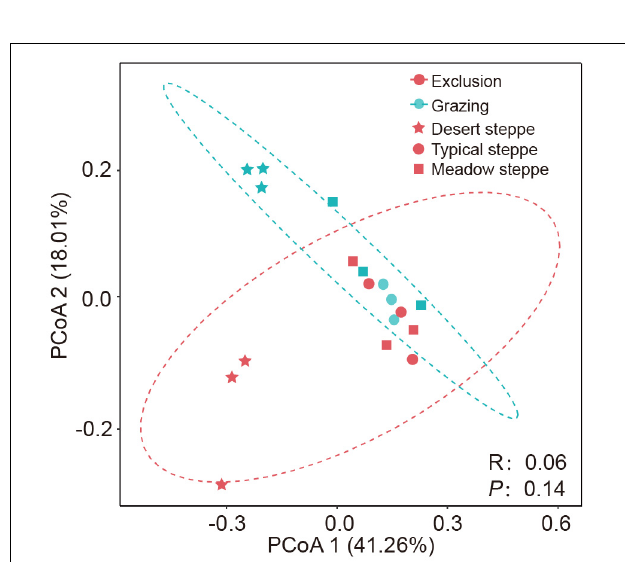
FIGURE 3 | Bacterial community structure assessed by β -diversity patterns using the principal coordinate analysis plots of Bray–Curtis distances. Different color represents exclusion or grazing soils and shape represents grassland types: desert steppe, typical steppe, and meadow steppe. ANOSIM similarity analysis was used to test the significance between